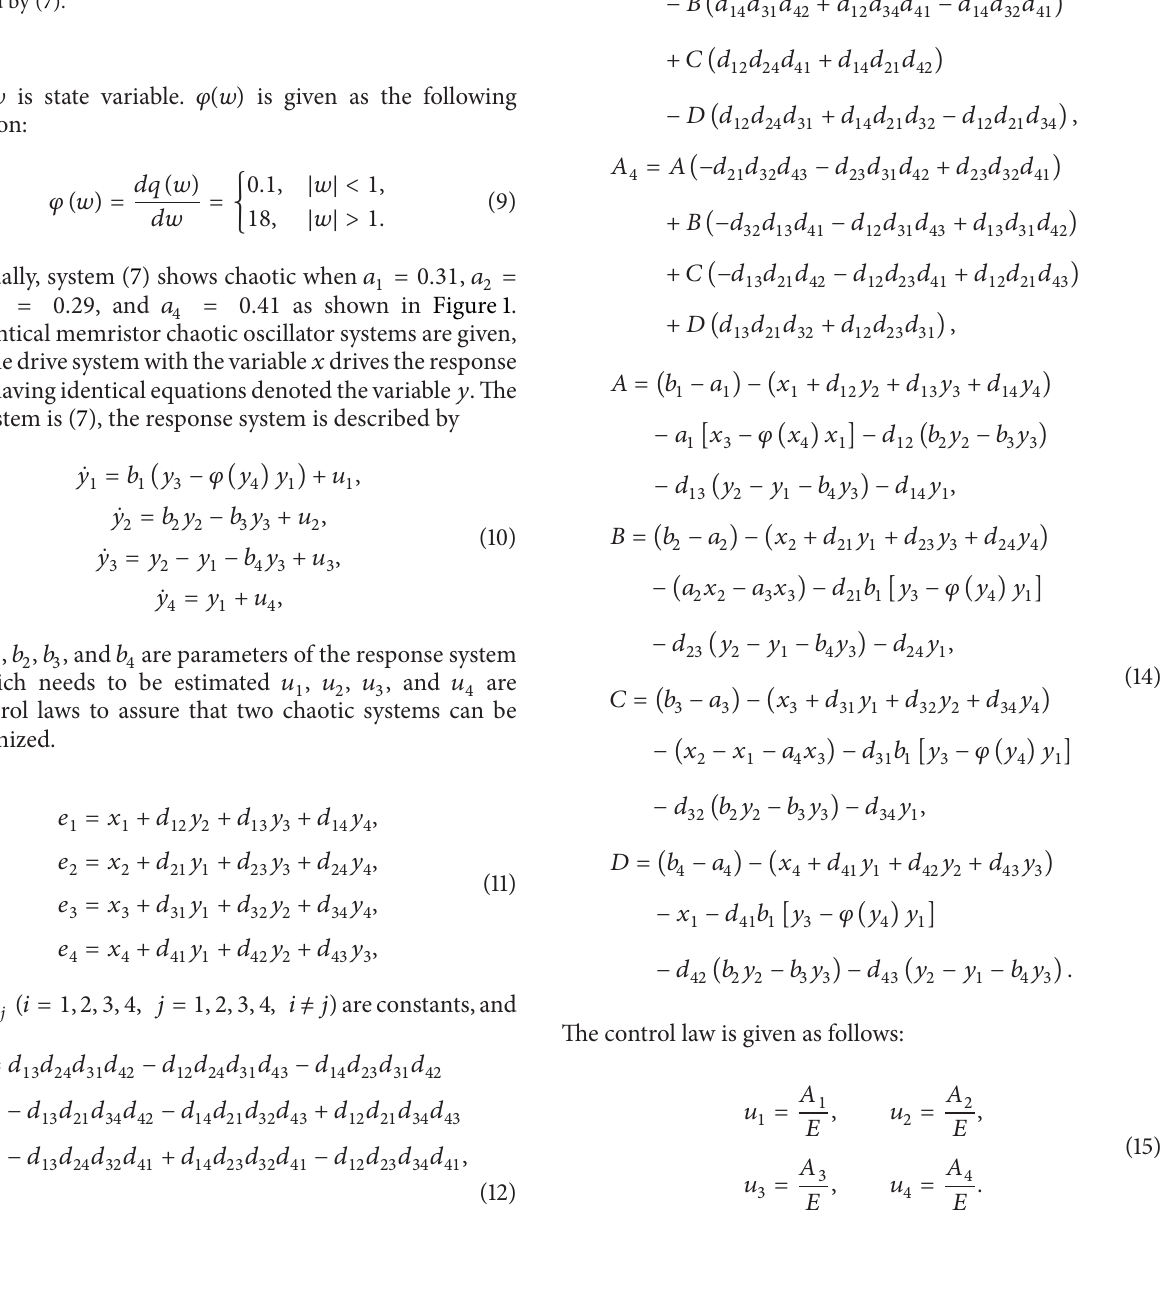
Figure 1: Chaotic attractors of memristor chaotic oscillator system described by